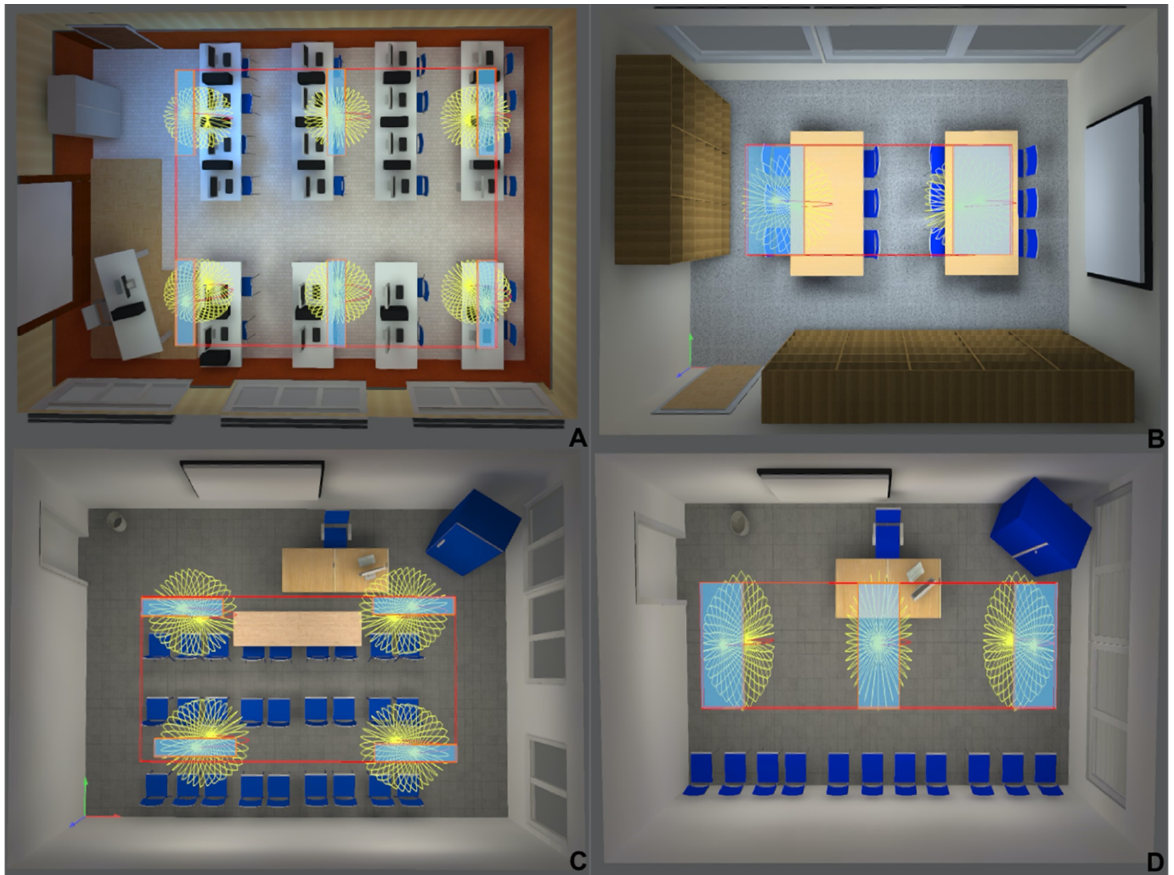
Figure 1. Simulated classrooms by DialuxEvo. ( A) Classroom 1; ( B) Classroom 2; ( C ) Classroom 3; ( D ) Classroom 4.